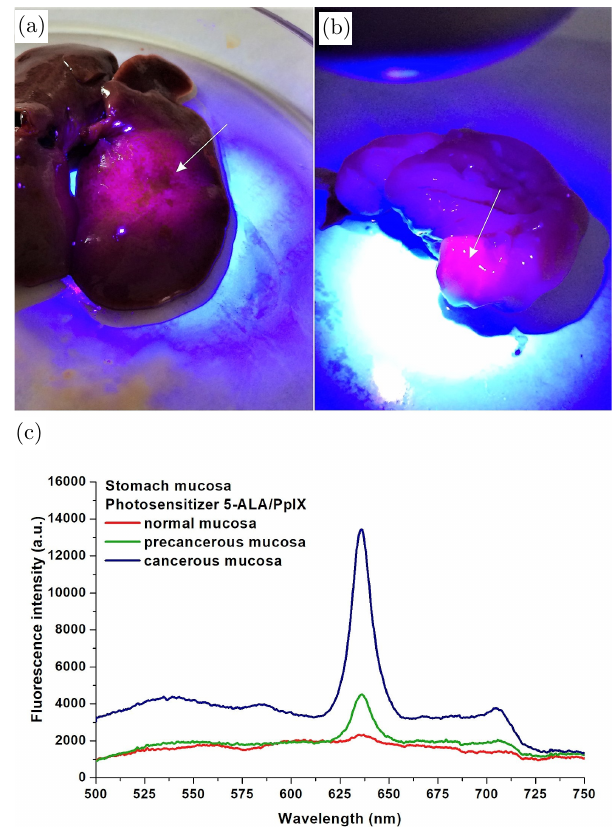
Fig. 2. Photodiagnosis of gastric cancer in rats with highly heterogeneous adenocarcinoma using 5-ALA/PpIX: (a) photo- analysis of °uorescence from normal and cancerous areas of the stomach (marked by arrow). The normal mucous membrane emits a bright blue signal compared to the red °uorescence emitted from the cancerous areas of the stomach (marked with an arrow), (b) the same from the liver and (c) comparison of the °uorescence spectra of normal, precancerous and cancerous stomach mucosa after photosensitization with 5-ALA/PpIX.